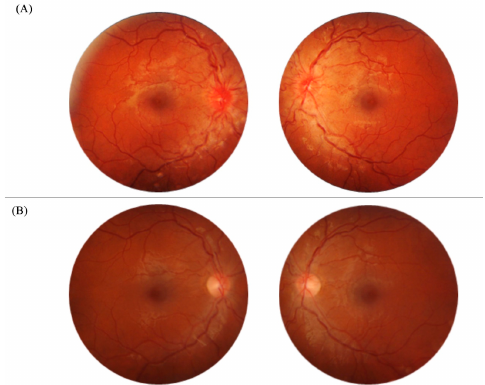
Figure 1. Right and left fundus on presentation, showing the hyperemic optic disc and tortuous vessels ( A ) and a normal fundus appearance after five months ( B ). Macular Optic coherence tomography (OCT) showed thickening of the disc’s retinal nerve fiber layer (RNFL) and thinning of the ganglion cell layer (GCL) (Figure 2A).